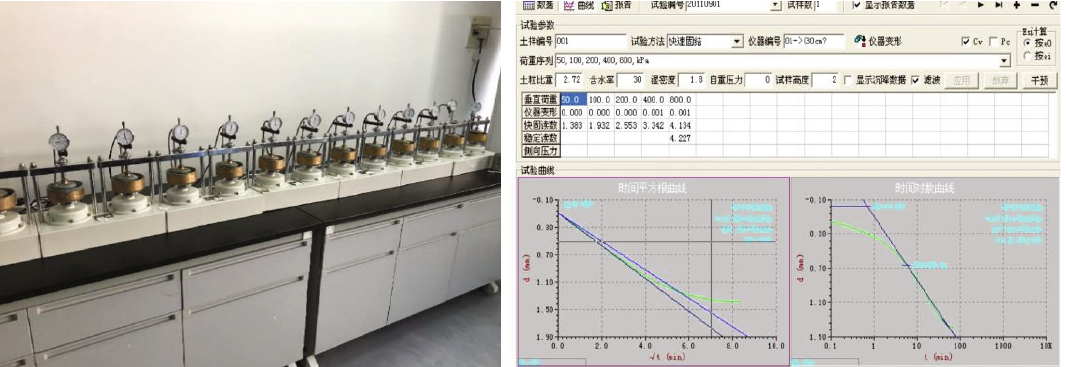
Figure 7: Automatic consolidation apparatus. Table 1: Scheme for one-dimensional compression tests.